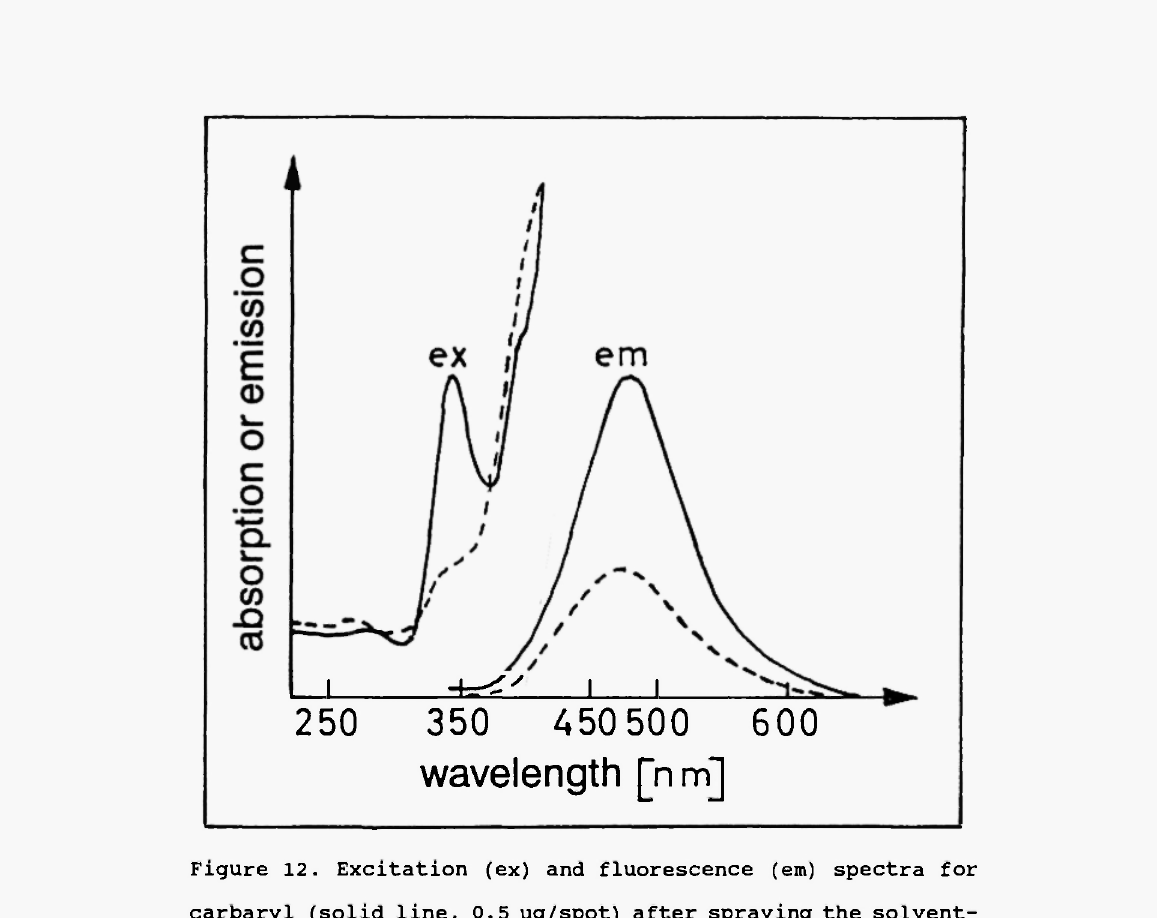
Figure 12. Excitation (ex) and fluorescence (em) spectra for carbaryl (solid line, 0.5 ug/spot) after spraying the solvent- free layer with 1 Μ sodium hydroxide; spectra of background silica gel are shown as dotted lines. (Reproduced with permission from TLC Report, IV./3-10, GIT Verlag